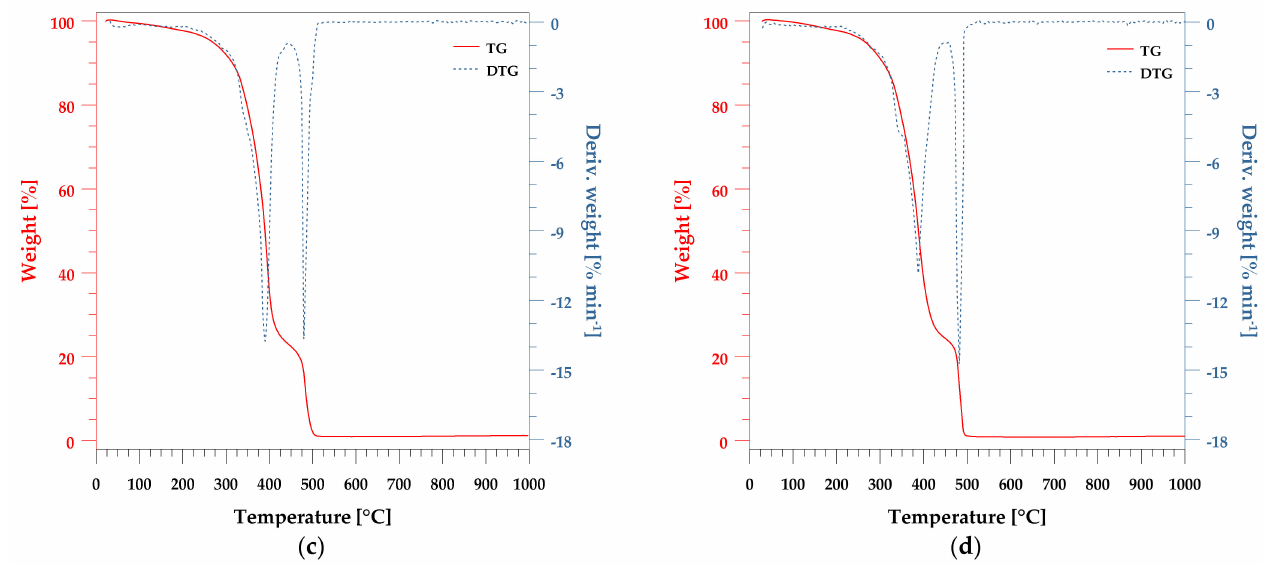
Figure 3. Thermal decomposition of the UPR/PSP composites. TG and DTG curves of ( a ) pure UPR; ( b ) UPR + 10; ( c ) UPR + 20, ( d ) UPR +